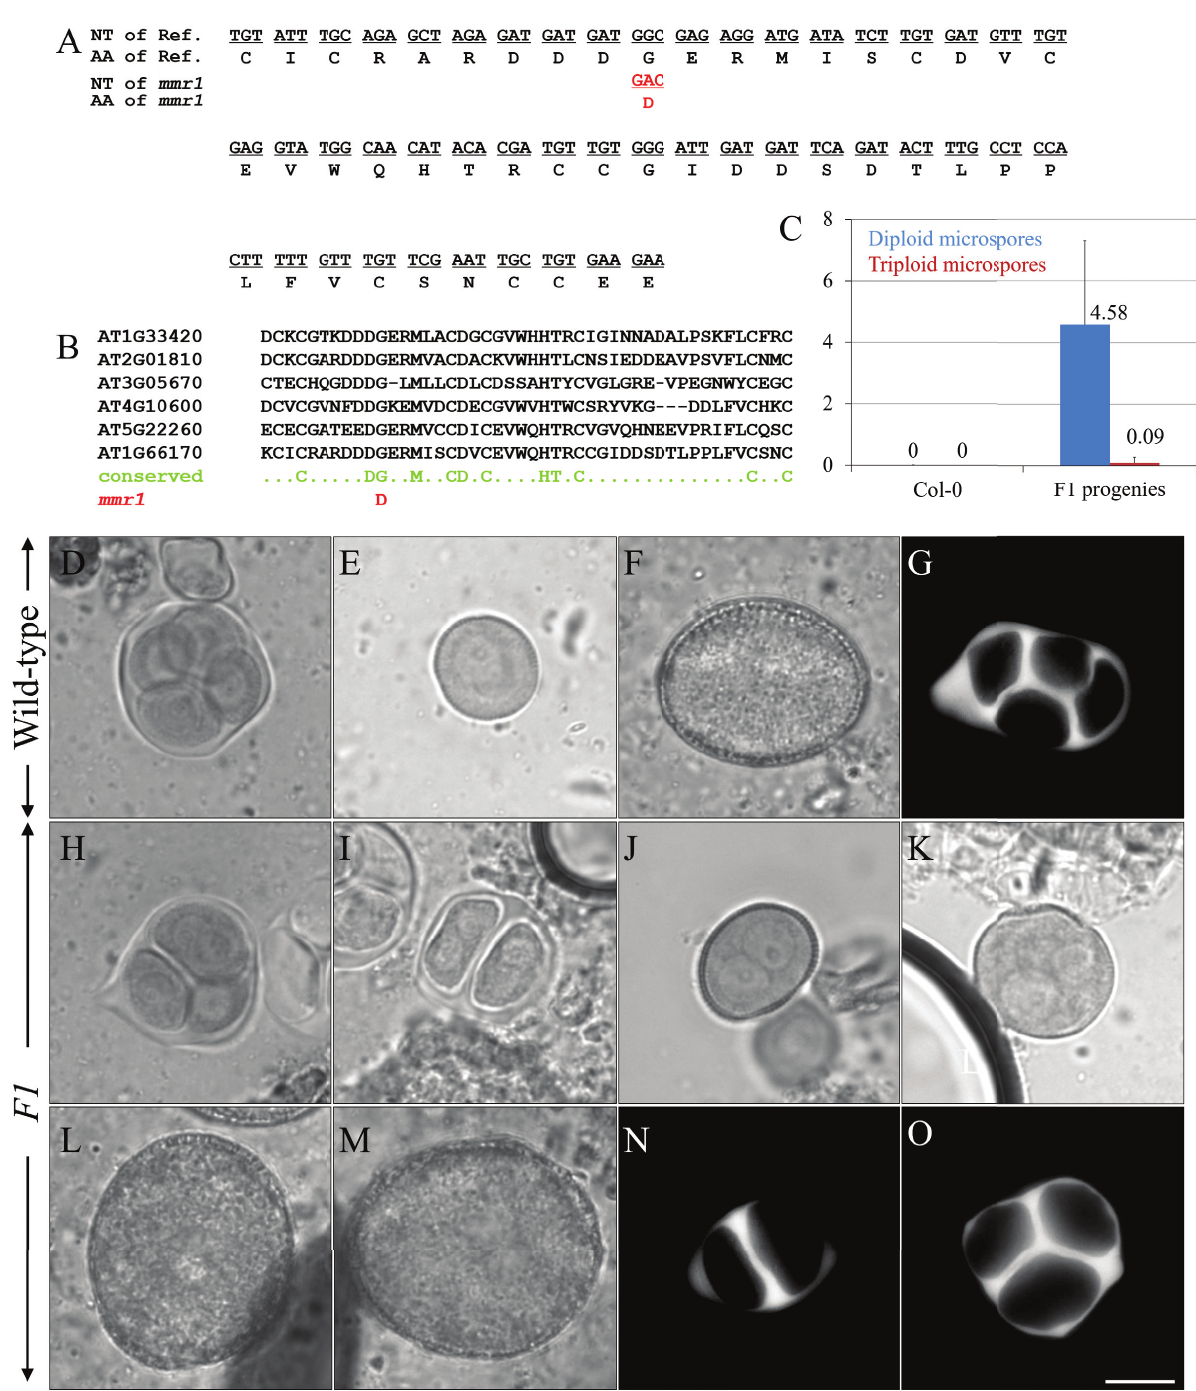
Figure 6. mmr1 is an allelic mutant of MMD1/DUET . ( A ) Figure showing the nucleotide (NT) sequence and amino acid sequence of the PHD domain in the MMD1/DUET gene and protein, and the changes of that in mmr1 . ( B ) Figure showing the conservation of the amino acid in the PHD domain in multiple histone binding proteins, and the point mutation-caused amino acid replacement in that of mmr1 . ( C ) Histogram showing the frequency of diploid and triploid microspores produced by mmr1 / mmd1 F1 progenies. Nine individuals were quantified. Numbers indicate the frequency of diploid and/or triploid microspores. ( D , H , I ) Orcein-stained tetrads in the Col-0 plants ( D ), and triad ( H ) and dyad ( I ) in the mmr1 / mmd1 F1 progenies. ( E , J , K ) Haploid unicellular stage microspore in the Col-0 plants ( E ), and diploid ( J ) and polyploid ( K ) unicellular- stage microspores in the mmr1 / mmd1 F1 progenies. ( F , L , M ) Haploid pollen grain in the Col-0 plants ( F ), and enlarged pollen grains in the mmr1 / mmd1 F1 progenies ( L , M ). ( G , N , O ) Aniline blue-stained meiotic cell walls in the Col-0 plants ( G ) and in the mmr1 / mmd1 F1 progenies ( N , O ). Scale bar = 10 µ